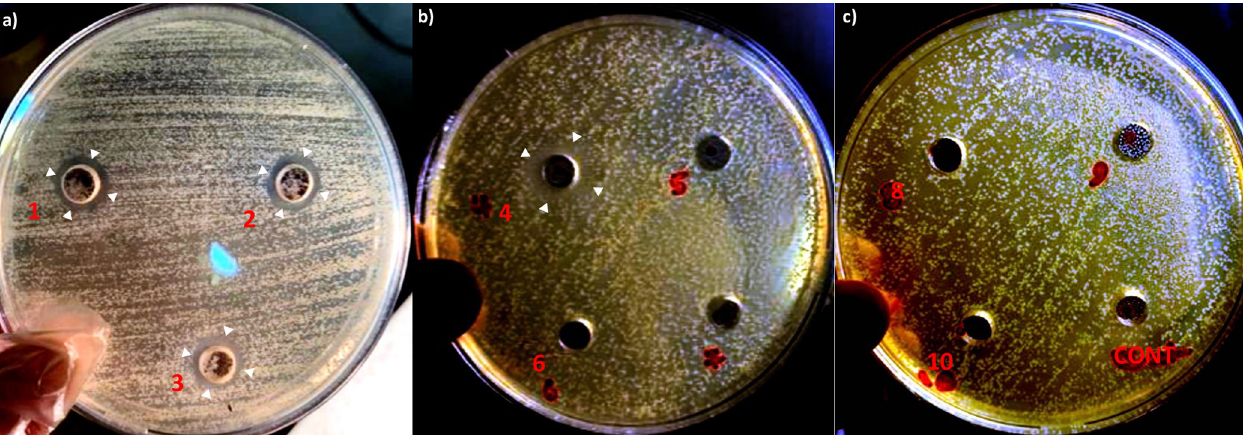
Fig 2. Final results of the well diffusion assay. First, standard C . albicans preparations (0.5 McFarland, 1–5 x 10 6 CFU/mL) were spread on SDA plates and eleven sample wells were created. The wells numbered from 1 to 10 in the photographs (a) , (b) , and (c) were then filled with serial concentrations of FTY720 from 1.5 to 0.005 mg/mL respectively. The well labelled as “CONT” in photograph (c) was filled with normal saline. Then, the plates were incubated for 30 hours in 37˚C, after which, the results were documented and the depicted photographs were taken. Zones of inhibition (white arrowheads) are visible surrounding the wells numbered from 1 to 4 in the photographs (a) and (b) , corresponding to serial concentrations of FTY720 from 1.5 to 0.5 mg/mL. Abbreviations: SDA, Sabouraud dextrose agar; CONT, control; CFU, colony forming unit.